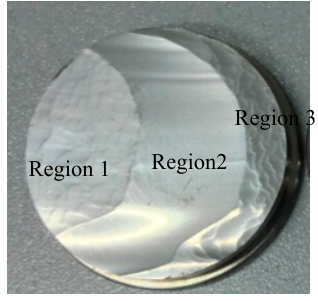
Figure 18. Wear of test sample at 225 mm.